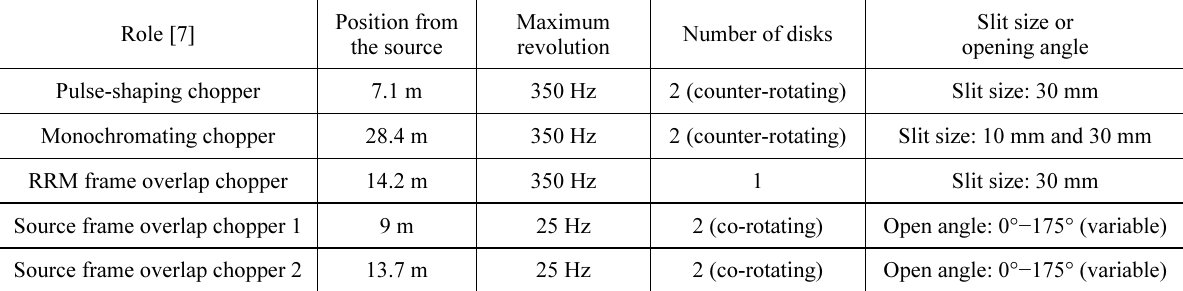
Table 1. AMATERAS chopper